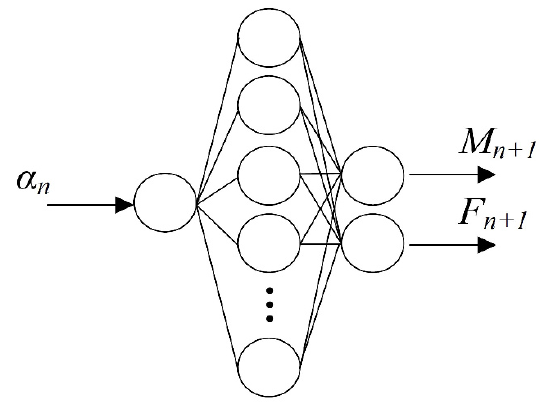
walking) is plotted, see Figure 2.